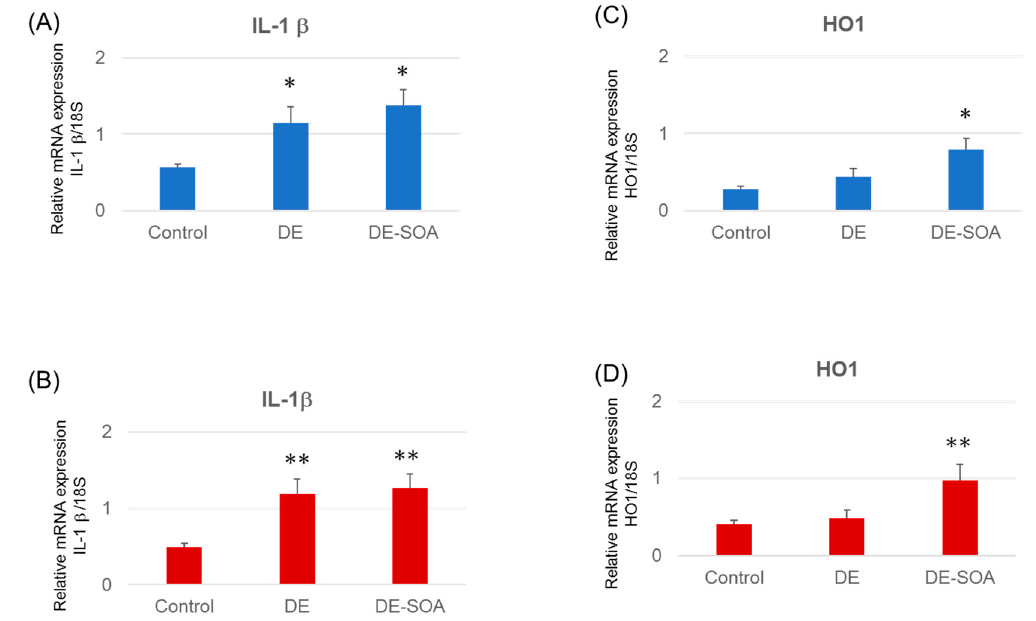
Figure 5. mRNA expression levels of immunological biomarkers. ( A , B ) IL1 ‐β and ( C , D ) HO ‐ 1 in the prefrontal cortex of the control and the DE ‐ and DE ‐ SOA ‐ exposed male and female rats. ( n = 14, ** p < 0.01 vs. control; * p < 0.05 vs. control).